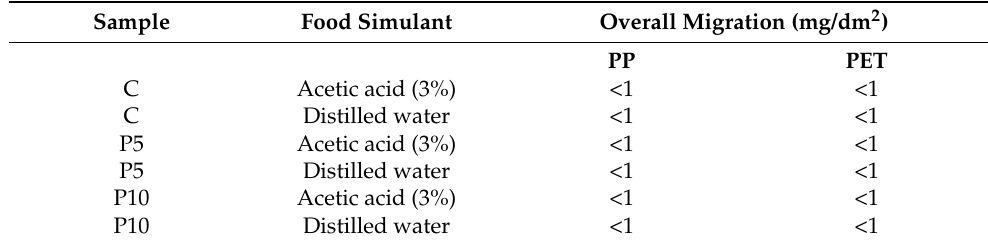
Table 5. Overall migration (mg/dm 2 ) related to the PP and PET samples.